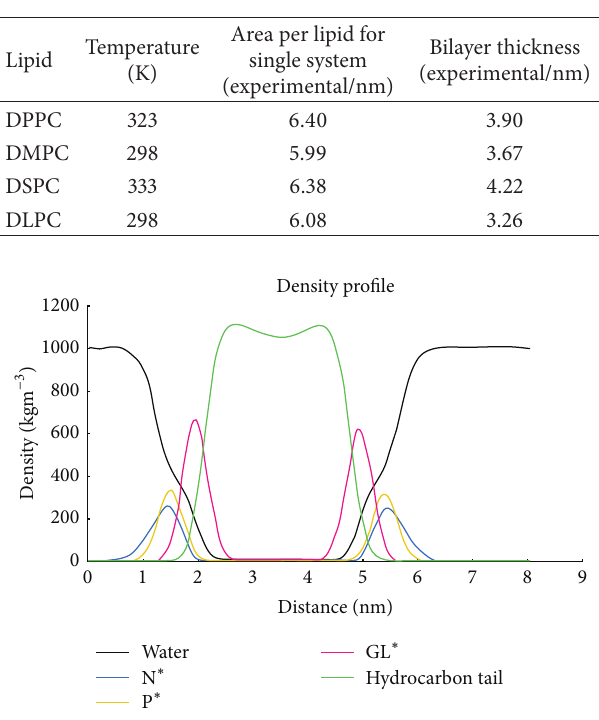
Table 1: The average areas per lipid molecule obtained from avail- able experimental measurements.